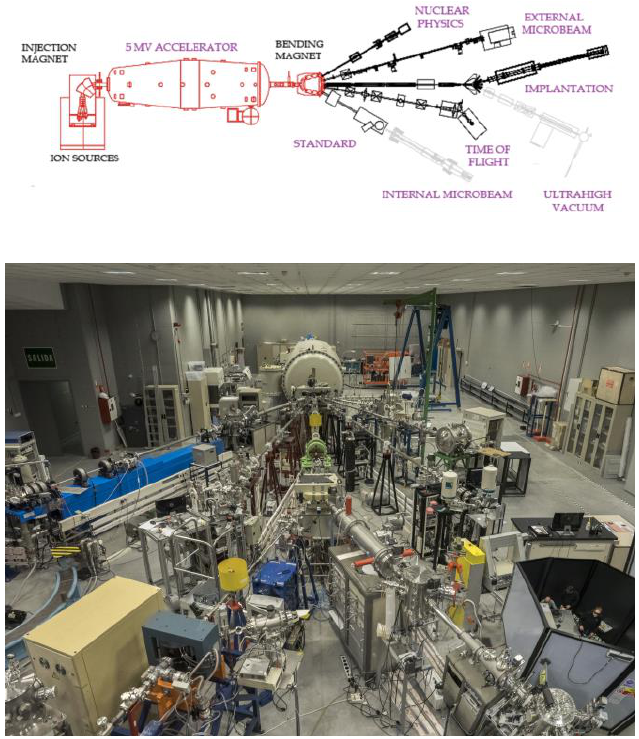
Fig. 1. (a) Scheme of the accelerator hall with the experimental lines identified. (b) Picture of the CMAM accelerator hall from point of view of the end of the experimental